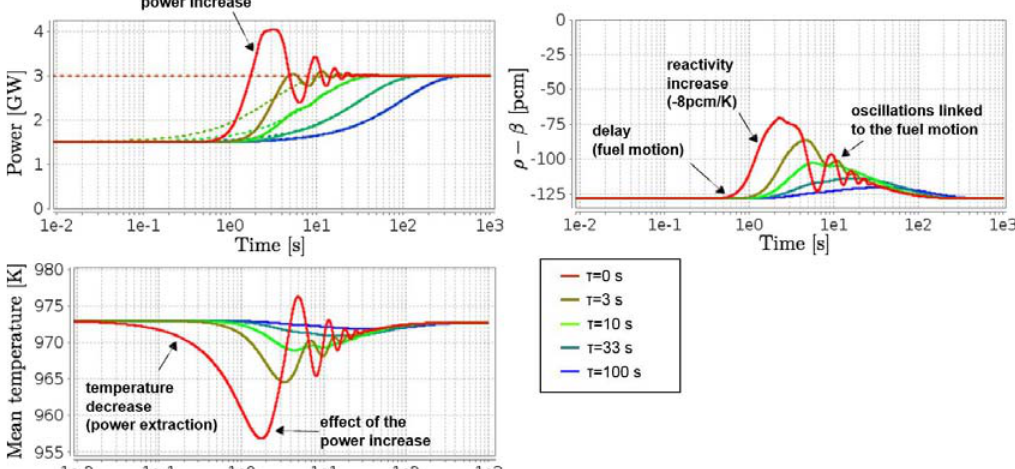
Figure 1. Load following transients from 1.5 to 3 GW simulated with the LiCore code by varying the power extracted in the heat